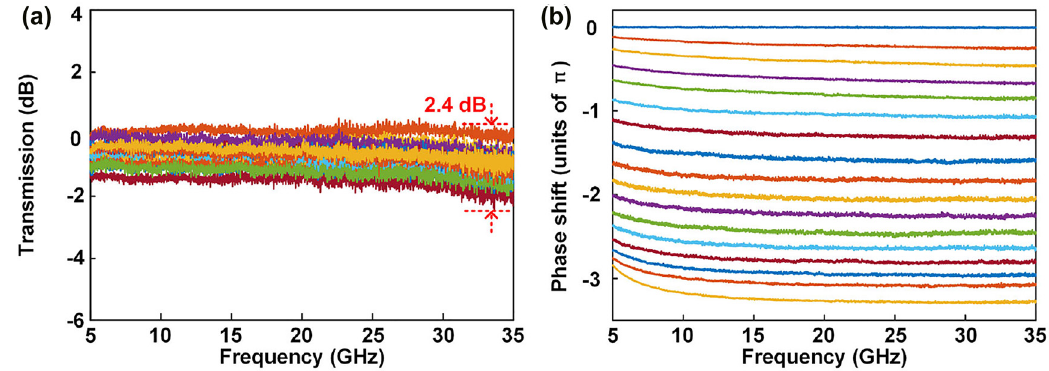
Figure 7: Measured frequency responses of the microwave photonic phase shifter.